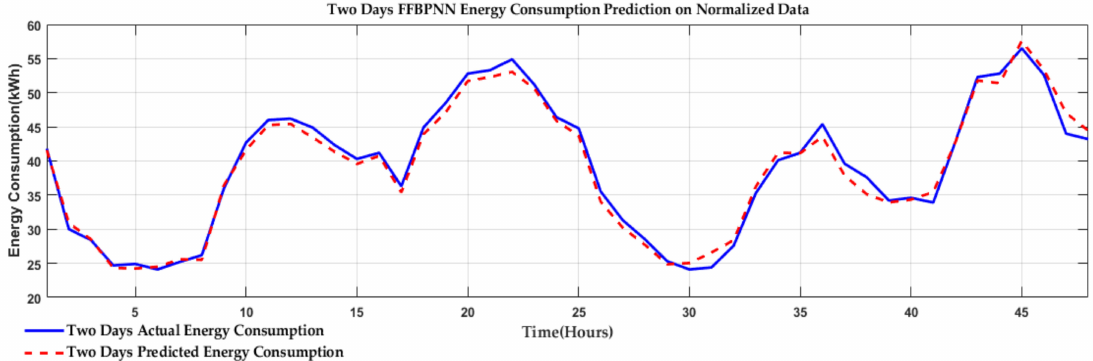
Figure 13. One day hourly energy consumption prediction using FFBPNN on normalized data.